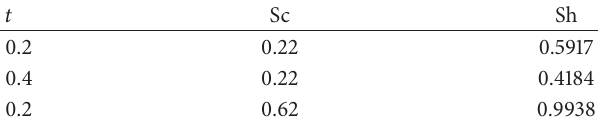
Table 3: Sherwood number variation.